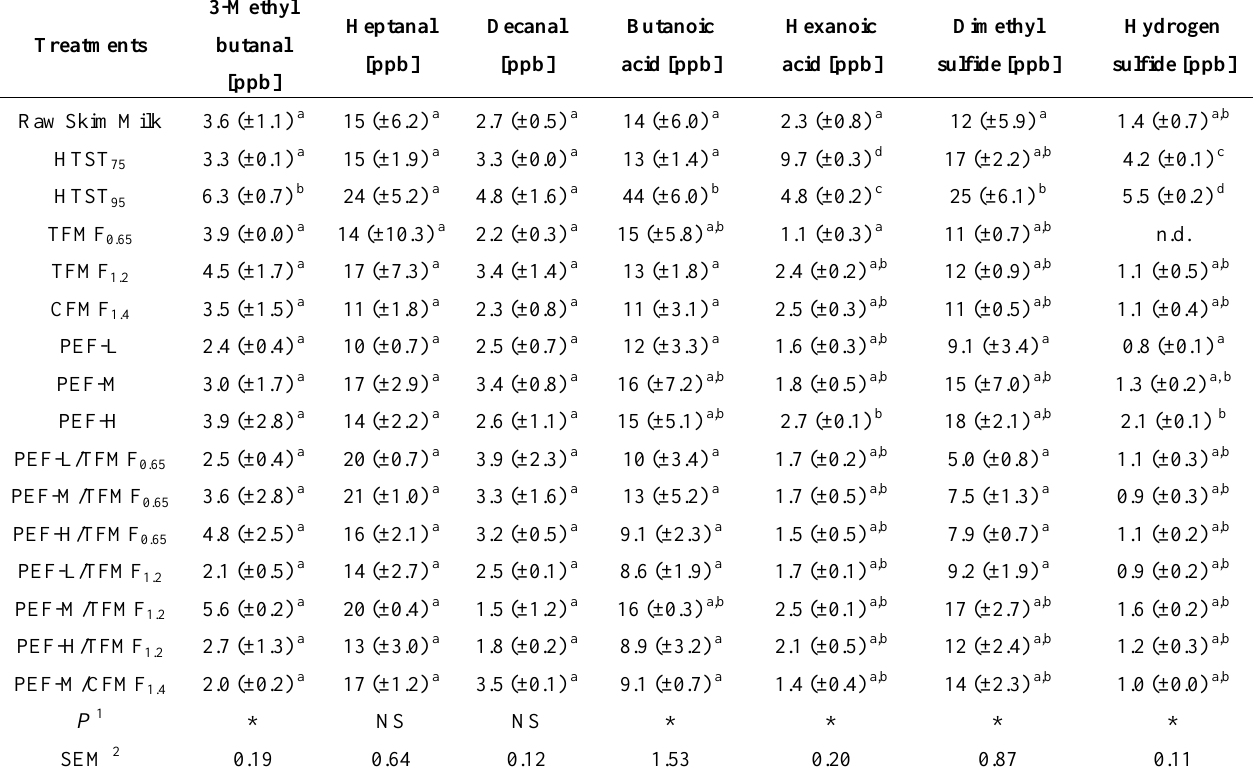
= 75 °C for 20 s; HTST = 95 °C for 45 s) and lab-scale 75 95 = 0.65 µm; TFMF = 1.2 µm), pilot 0.65 1.2